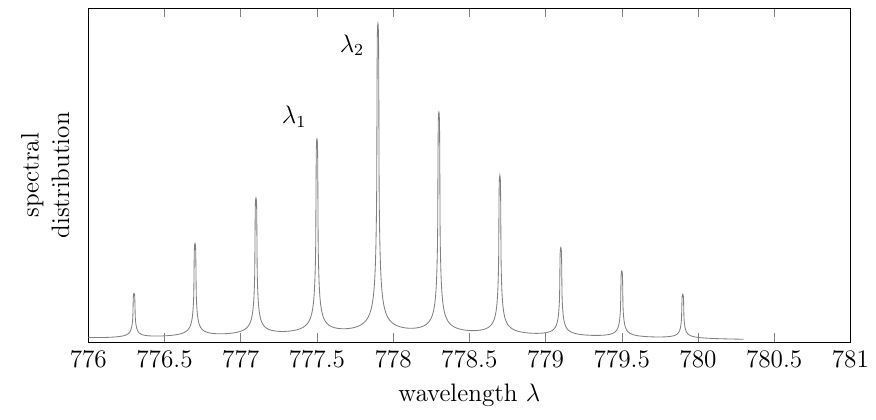
Figure 2. Average spectral distribution for GaAsP lasers at the nominal temperature of 21 °C